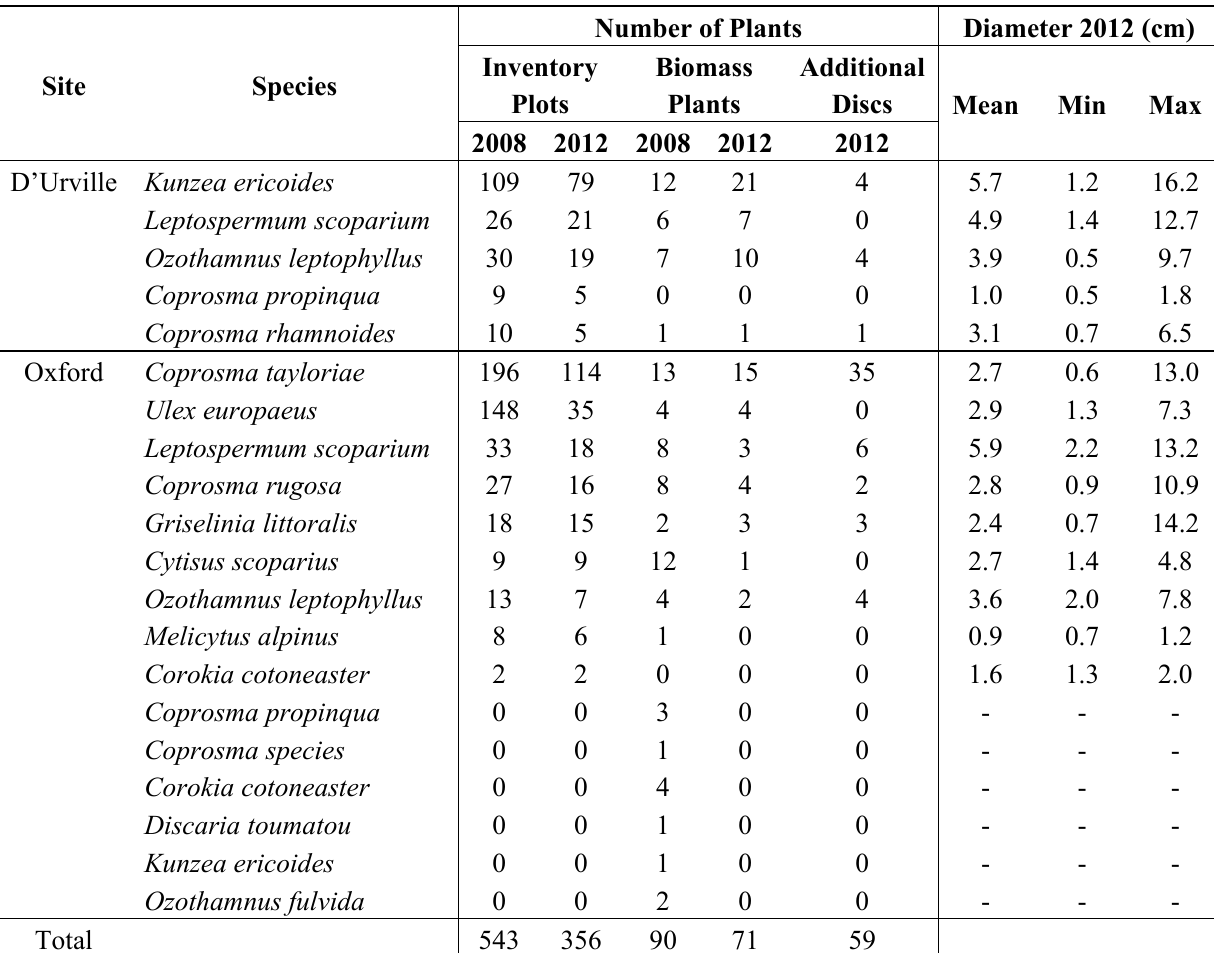
Table 1. Numbers of plants measured in the 5 × 5 m inventory plots, biomass plants, and plants sampled to obtain additional discs, by species and site. Also shown are mean, minimum and maximum diameters 10 cm above-ground of plants measured in inventory plots in 2012. Diameters of multi-stemmed plants were calculated as the square root of the sum of squared